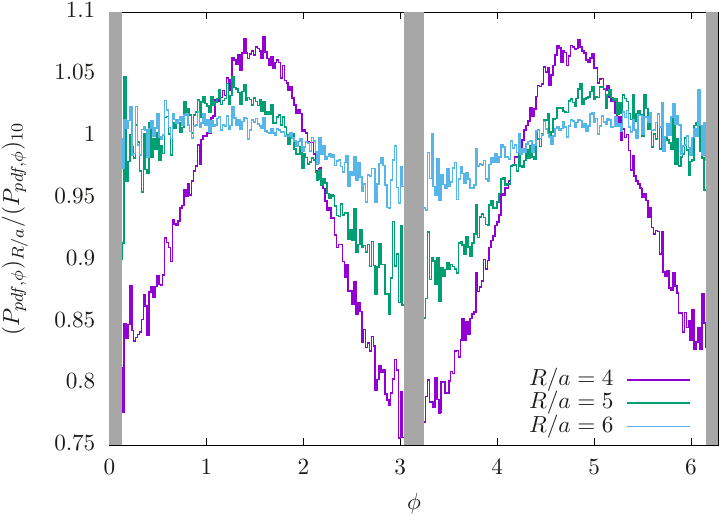
Figure 9 . Per-site distribution of the Polyakov phase φ for different R/a normalized with respect to the distribution at R/a = 10, which is close to the Haar measure. The histogram has been determined the same runs as in figure 6. The normalization of the histogram generates large errors in the regions close to 0 mod π , corresponding to the gray bands in the plot. These regions have been